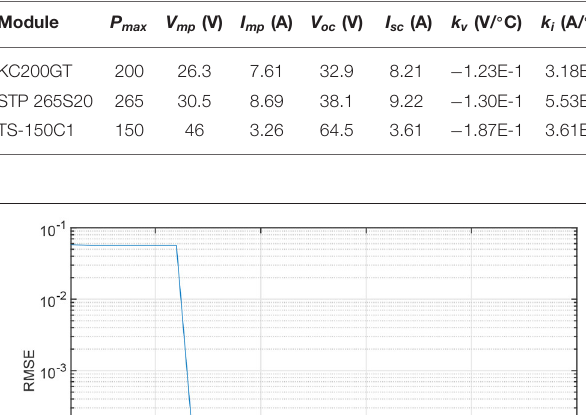
TABLE 1 | Electrical characteristics of the used PV modules.